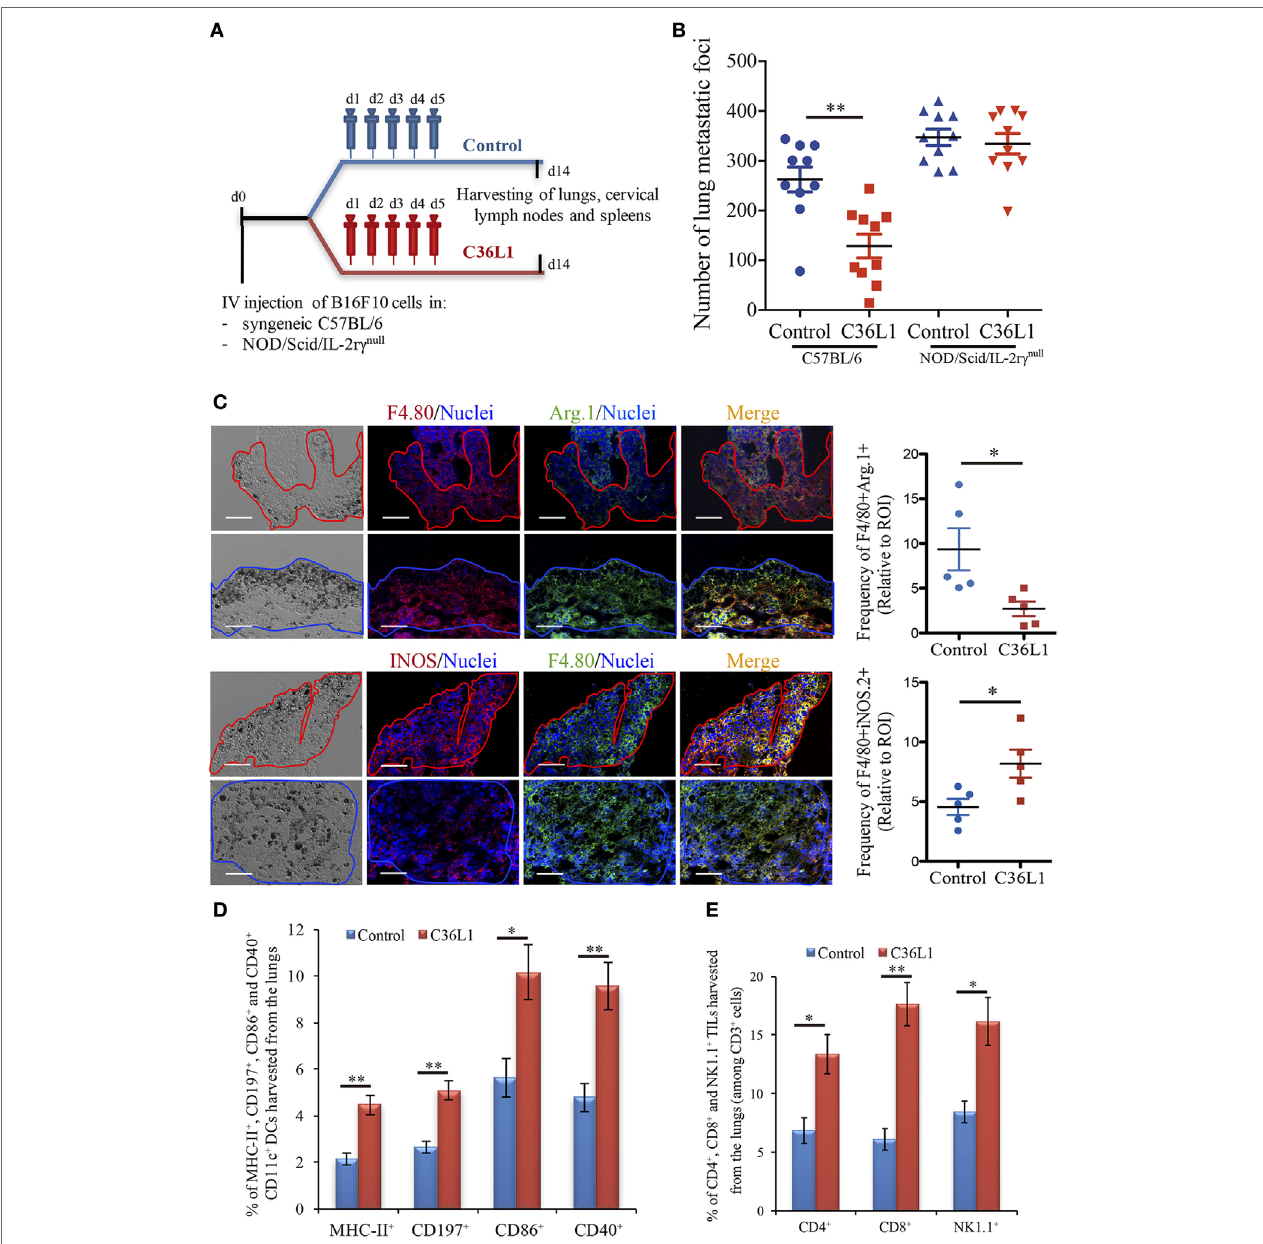
FigUre 1 | The antimetastatic effect of the C36L1 peptide depends on the immune system. (a) Metastatic melanoma model and therapeutic strategy using C36L1 peptide and control vehicle (PBS). At end point, lungs, cervical lymph nodes, and spleens are harvested. (B) Number of metastatic foci in immunocompetent (wild type) and immunodeficient (NOD/Scid/IL-2r γ null , NSG) mice treated with control vehicle (PBS) or C36L1 peptide. n = 10 mice per group (two combined experiments). Values are expressed as means ± SEM and were analyzed using a two-tailed unpaired t -test (** p = 0.001). Graph combines two independent experiments. (c) Left: Immunofluorescent staining and quantification of F4/80 + Arg.1 + M2-like and F4/80 + iNOS + M1-like macrophages in lung metastasis from C36L1- and control vehicle-treated mice. Melanoma lung metastatic area appears in dark/brown color in brightfield images. Right; Graphs show quantification of positive F4/80 + Arg1 + (* p = 0.028) and F4/80 + iNOS + (* p = 0.02) stainings. Nuclei were counterstained with Hoechst 33342 (blue). N = 5 mice per group; at least five fields assessed per sample. Values are expressed as means ± SEM and were analyzed using a two-tailed unpaired t -test. Blue and red lines indicate the tumor area in C36L1- and control vehicle-treated mice, respectively. Scale bars: 50 µm. (D) Flow cytometry quantification of activation markers MHC-II (** p = 0.003), CD197 (** p = 0.002), CD86 (* p = 0.019), and CD40 (** p = 0.007) expressed in CD11c + dendritic cells (DCs) isolated from lungs of C36L1- and control vehicle-treated mice. Data represent quantification of four independent experiments with five pooled lungs per group for each experiment. Values are expressed as means ± SEM and were analyzed using a two-tailed, unpaired t -test. (e) Quantification of CD4 + (* p = 0.03), CD8 + (** p = 0.005), and NK1.1 + (* p = 0.02) cells among CD3 + cells in lung metastatic lesions from C36L1- and control vehicle-treated mice. Bar graphs combine three independent in vivo experiments with five pooled lungs per group for each experiment. Values represent means ± SEM and were analyzed using a two-tailed unpaired t